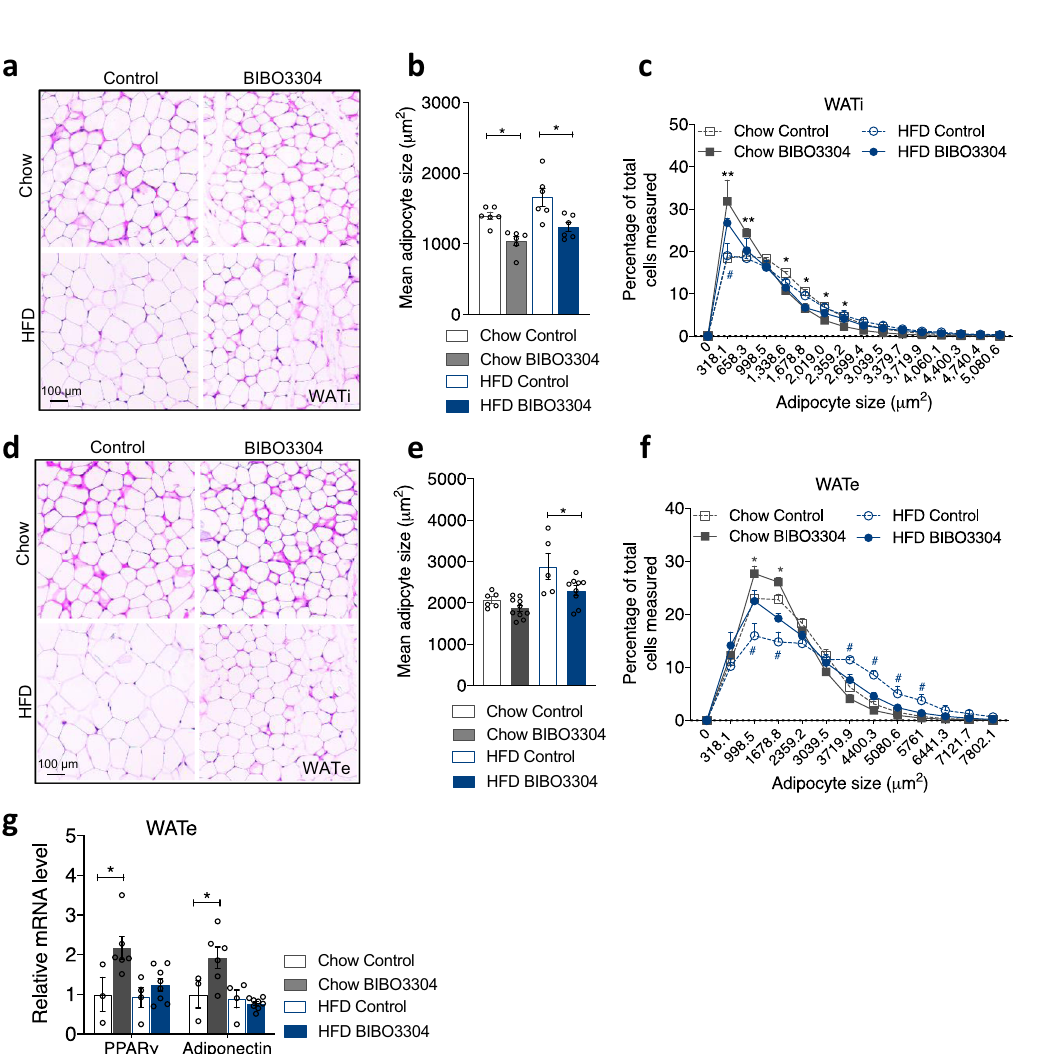
Fig. 5 Peripheral Y1R antagonism induces browning of white adipose tissue. a The mRNA levels of thermogenic and lipogenic markers in inguinal WAT (WATi) of chow- and HFD-fed wild-type mice on a daily administration with a jelly containing a vehicle or BIBO3304. b mRNA levels of beige adipocyte- related genes in WATi. c mRNA expression of PPAR γ , adiponectin , and β 3R in WATi of chow- and HFD-fed wild-type mice on a daily administration with a jelly containing vehicle or BIBO3304. Data ( a , b , c ) are mean ± s.e.m, n = 3 in chow control (open grey), and 5 in chow BIBO3304 (grey); n = 4 in HFD control (open blue), and 8 in HFD BIBO3304 (blue). * p < 0.05, ** p < 0.01, two-way ANOVA with Sidak ’ s multiple comparisons test. d Western blot analyses of UCP1, PGC1 α and p-ACC protein levels in the WATi of vehicle- or BIBO3304-treated mice. 14-3-3 was used as a loading control. Images are representative of three independent experiments. KD kilodalton. e Quanti fi cation of the protein levels normalized to total protein content in BAT or WATi. Data are mean ± s.e.m, n = 3 in chow (control: open grey; BIBO3304: grey) or 4 in HFD (control: open blue; BIBO3304: blue). *** p < 0.001, two-way ANOVA with Sidak ’ s multiple comparisons test. f Representative immunohistochemical images of UCP1 protein expression in WATi of wild-type mice on either vehicle or BIBO3304 jellies for 7 weeks. n = 3 per group. g The mRNA levels of thermogenic and adipogenic markers in inguinal WAT (WATi) of Y1R − / − mice compared to wild type mice. Data are mean ± s.e.m, n = 4 per group (WT: mustard; Y1R − / − : purple). # p < 0.05, ## p < 0.01, Y1R − / − versus wild type determined by two-tailed t test. h The mRNA levels of thermogenic genes in WATi of chow- and HFD-fed Y1R − / − mice given either vehicle jelly or BIBO3304 jelly daily for 7 weeks. Data are mean ± s.e.m, chow n = 4 (control: open purple; BIBO3304: open green), HFD n = 6 (control: purple; BIBO3304: green). # p < 0.05, ## p < 0.01, two-way ANOVA with Sidak ’ s multiple comparisons test. Source data are provided as a Source Data fi le.